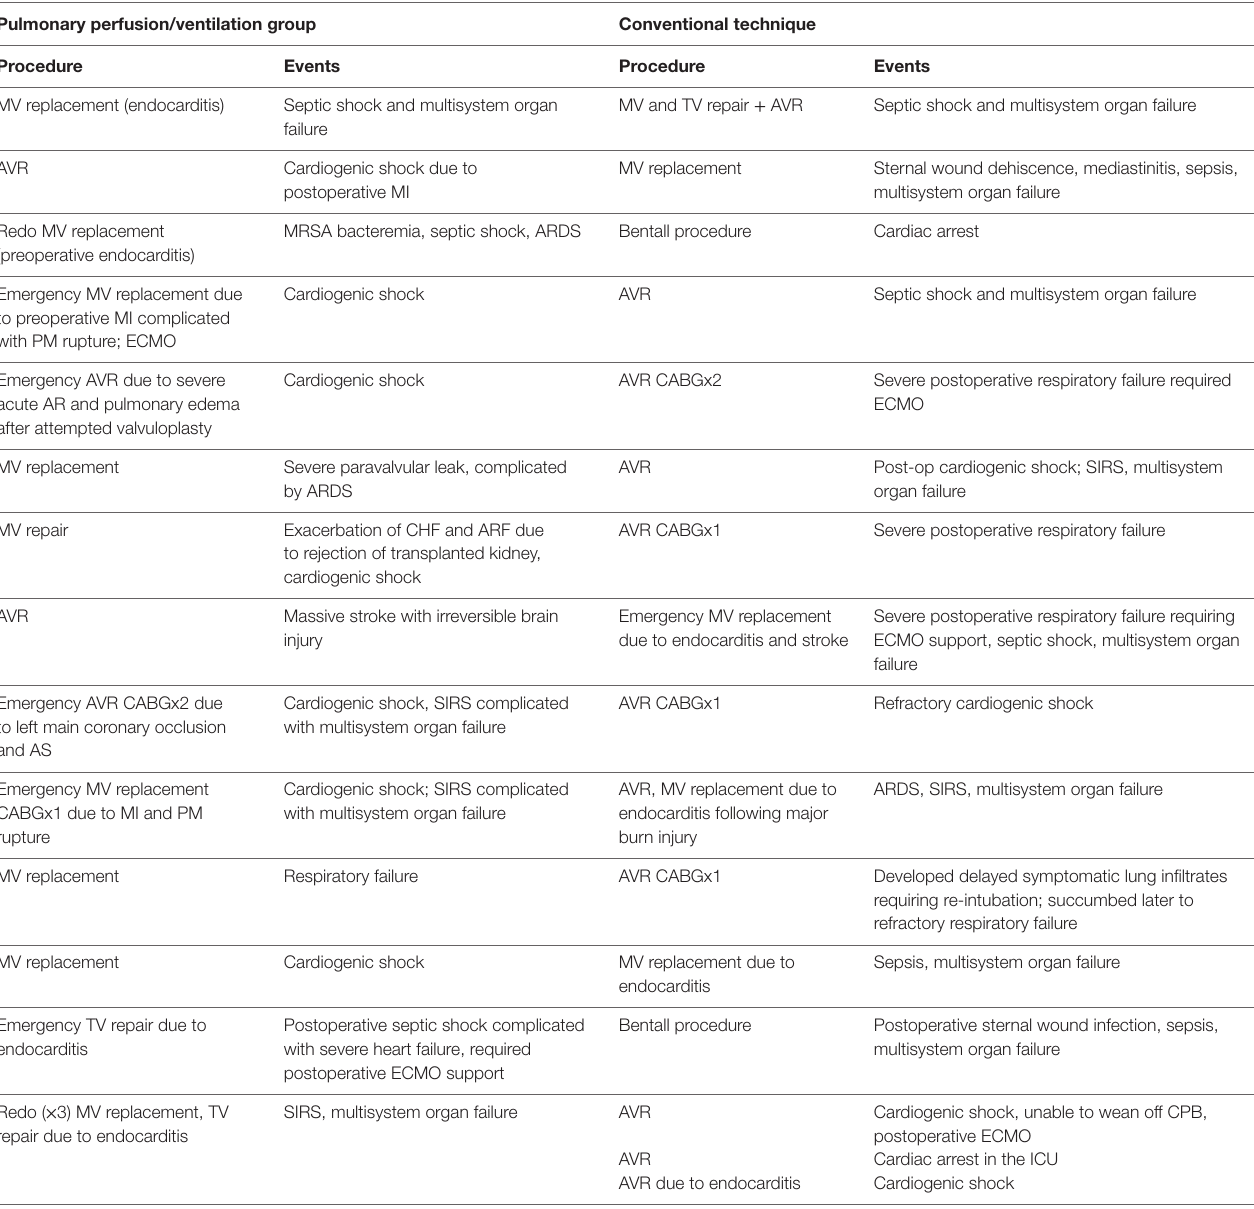
TaBle 5 | Mortality